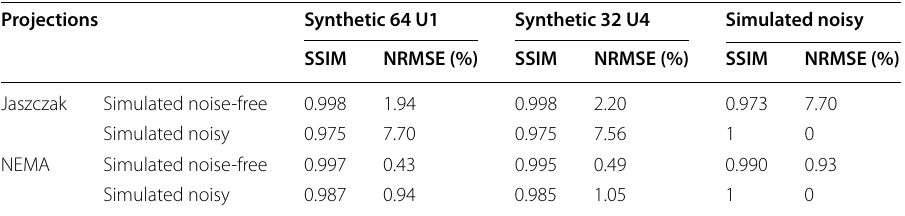
SSIM and NRMSE values between synthetic projections generated based on simulated noisy projections and simulated noise‑free and noisy projections,